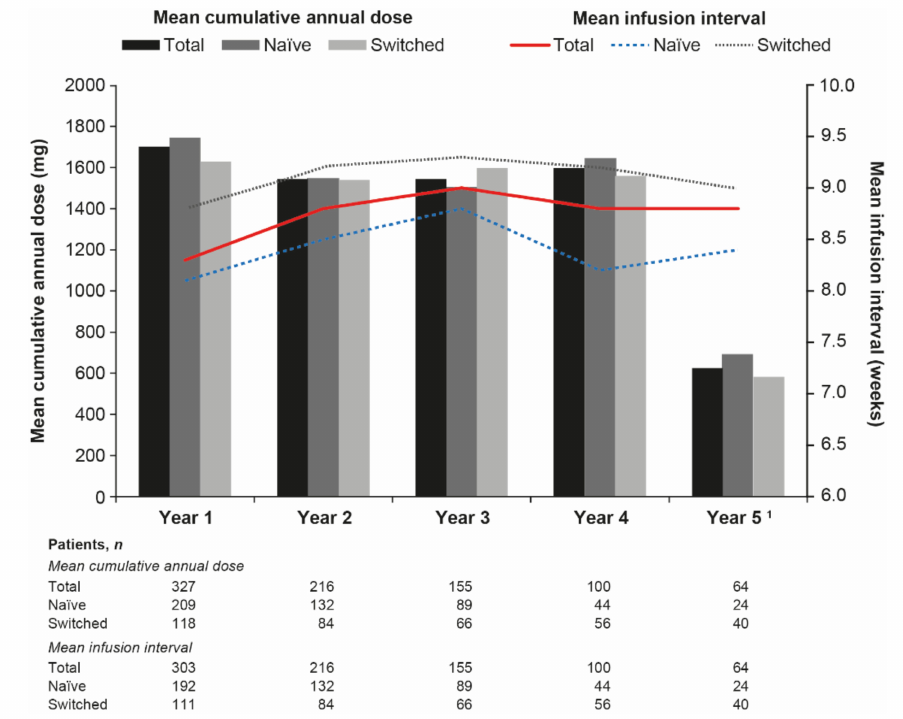
Figure 2. Mean cumulative annual maintenance dose and mean infusion interval by treatment group. Adapted with permission from Lee, S.S.; Kim, T.H.; Park, W.; Song, Y.W.; Suh, C.H.; Kim, S.; Yoo,